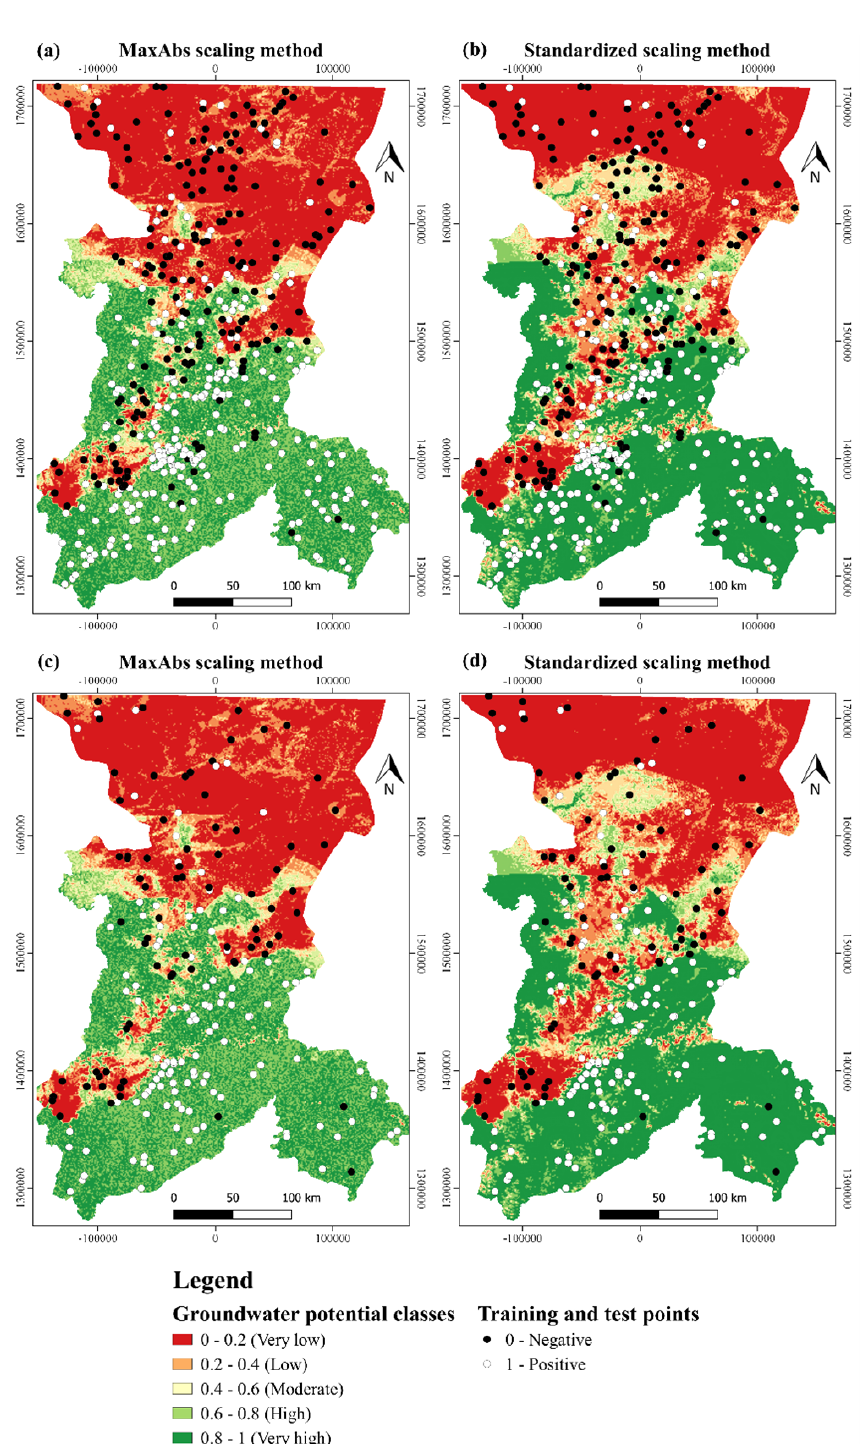
Figure 11. Mapping outcomes of the agreement map for the MaxAbs scaling method and standardized scaling method: (a) training points on the MaxAbs scaling method agreement map, (b) training points on the standardized scaling method agreement map, (c) testing points on the MaxAbs scaling method agreement map and (d) testing points on the standardized scaling method agreement map.